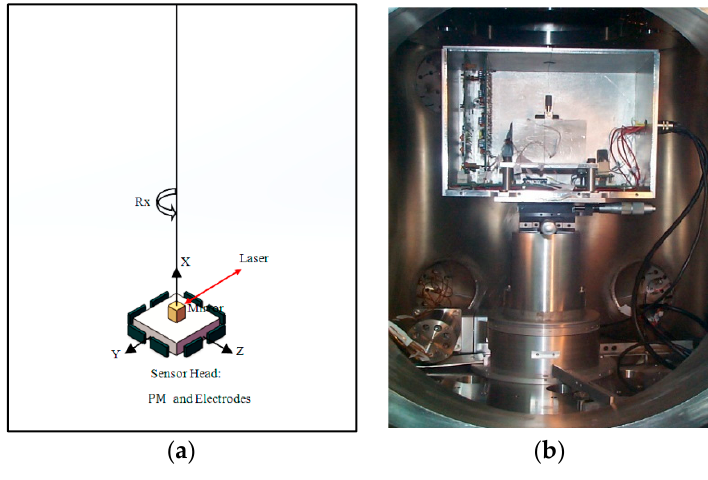
Figure 9. ( a ) Schematic of one-stage torsion pendulum; ( b ) experimental setup of torsion pendulum.